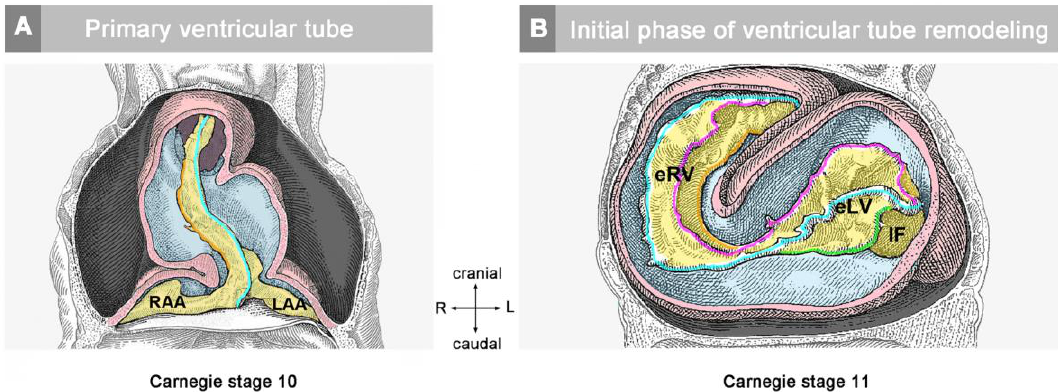
Figure 10. These drawings depict the changes in the outer shape of the occluded (systolic) endocardial tube of human embryonic heart tubes during the initial phase of ventricular tube remodeling. Hearts are shown in frontal views within the opened pericardial cavities. The ventral myocardial walls have been removed to facilitate views on the endocardial tubes. ( A ) The occluded endocardial tube of the primary ventricular tube has the shape of a flat band. Its ventral (blue line) and dorsal (orange line) edges correspond to the original ventral and dorsal midlines of the heart. ( B ) Due to the formation of trabecular shields, the occluded endocardial tube has a folded surface along